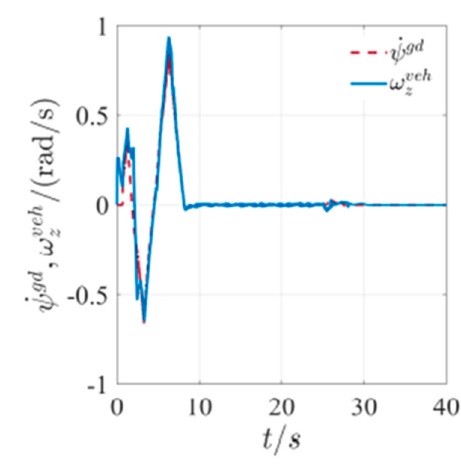
Figure 22. Attitude angle diagram of line tracking.